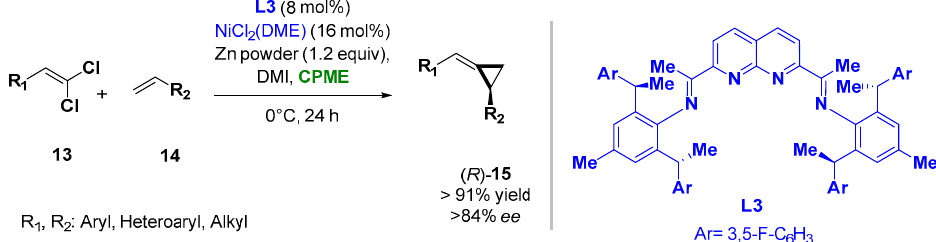
Figure 11. Asymmetric Ni-catalyzed alkylidene-cyclopropanes from olefines and gem- dichloroal- kenes.